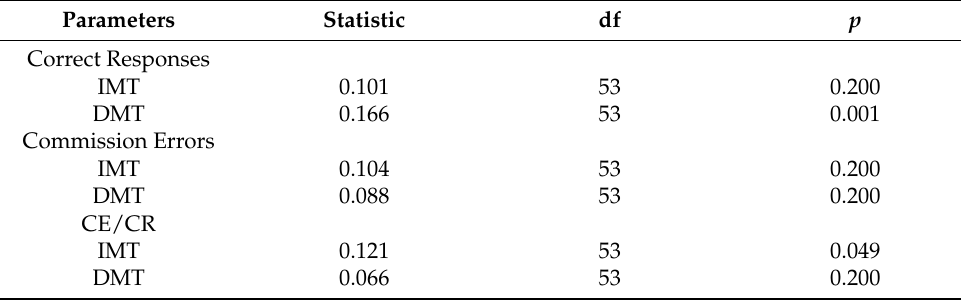
Table A2. Testing for parametric distribution in the IMT/DMT using the Kolmogorov–Smirnov test with significance correction according to Lillefors. Abbreviations: CE, commission errors; CR, correct responses; df, degrees of freedom; p ,